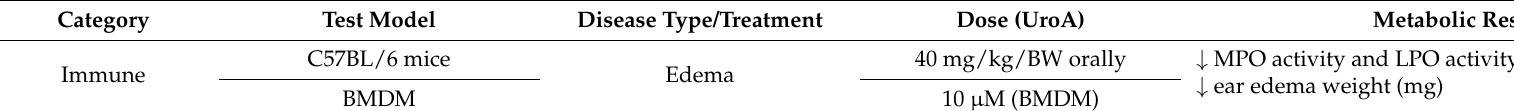
Table 1. Immunomodulatory function of